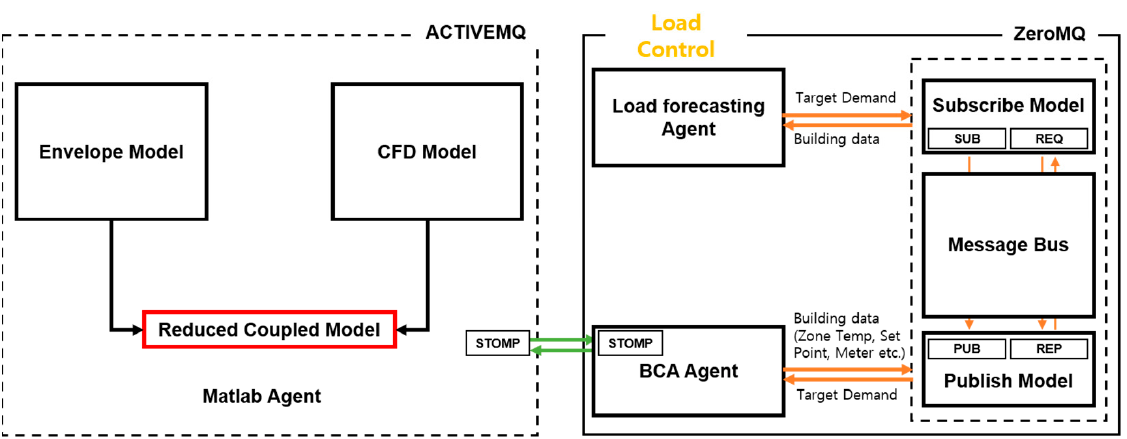
Figure 8. Simulation implementation of the building control algorithm.